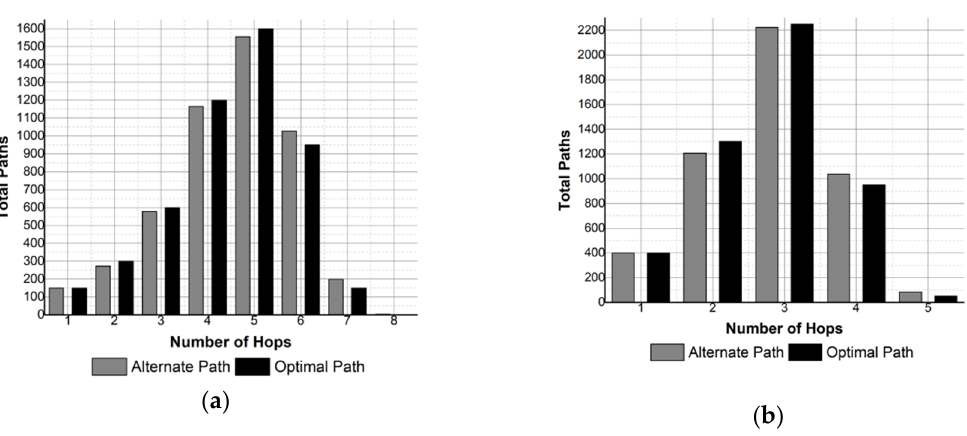
Figure 15. Number of hops for 100 nodes and different transmission ranges: ( a ) 70 m, ( b ) 100 m.